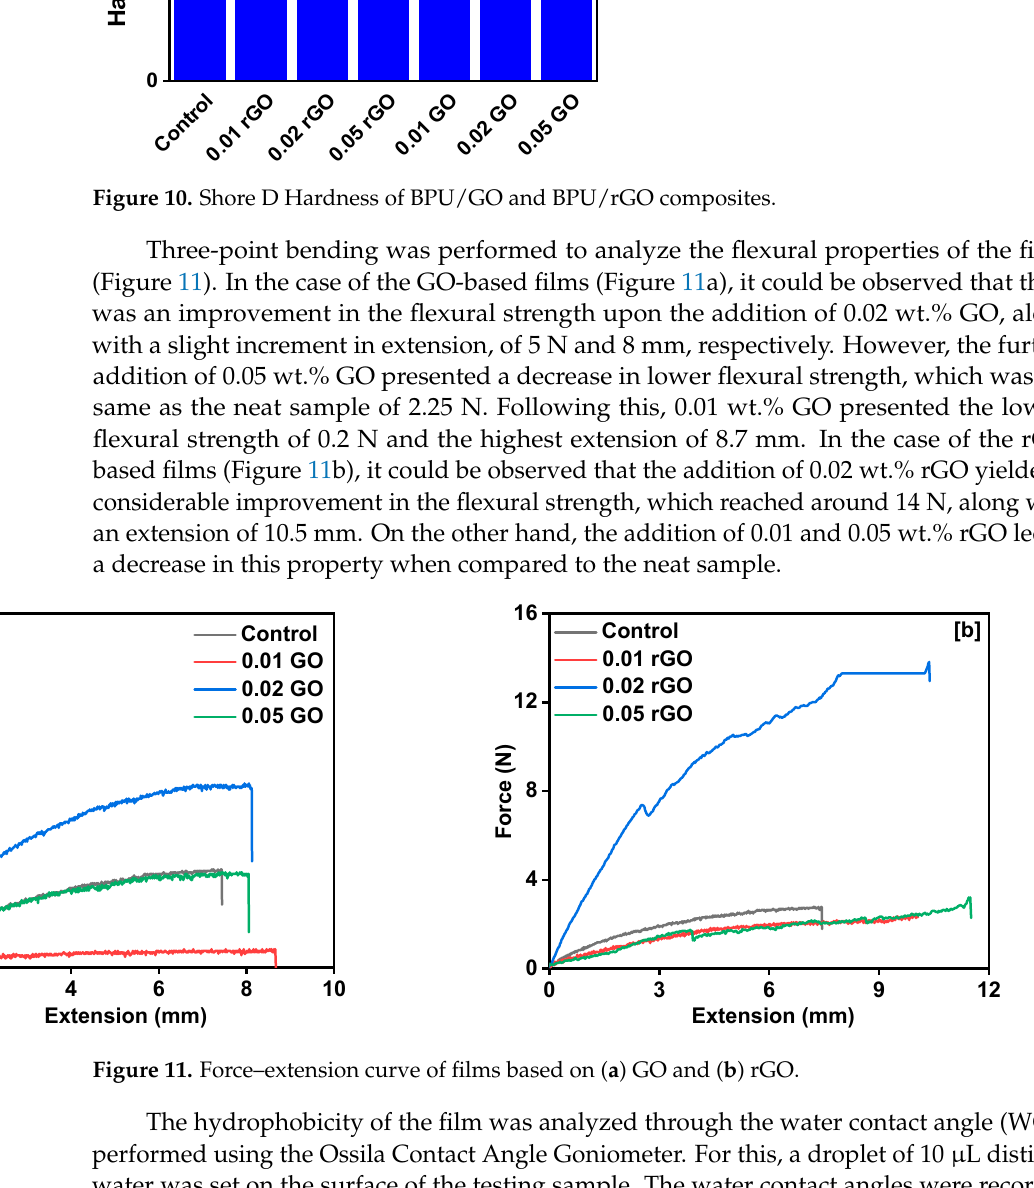
tilled water was set on the surface of the testing sample. The water contact angles were recorded